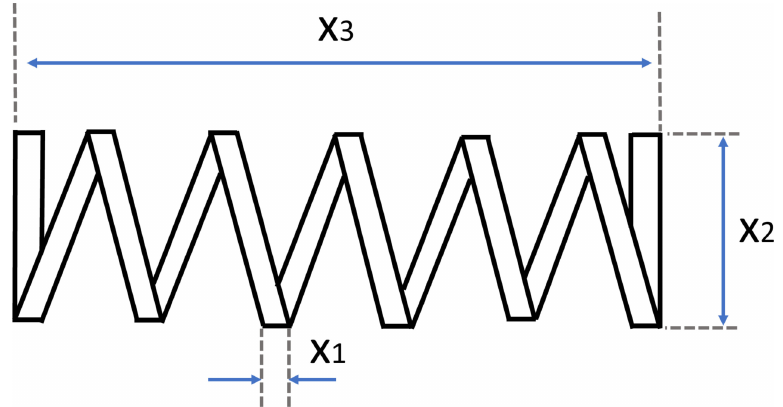
Figure 1. Schematic view of the tension/compression spring problem.